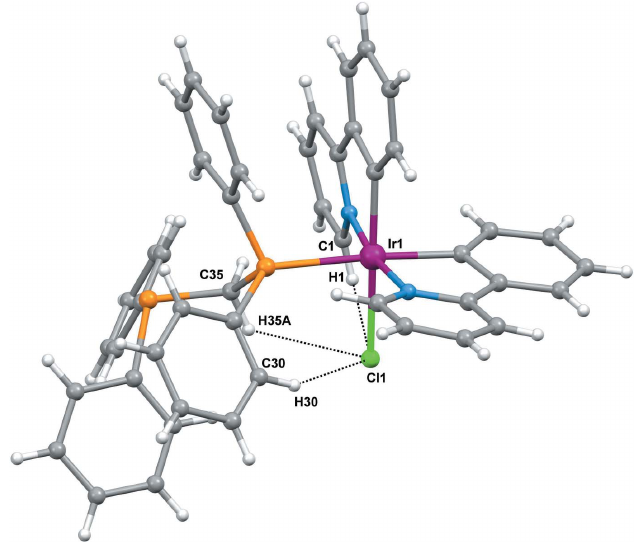
Figure 3 The intramolecular C—H (cid:3)(cid:3)(cid:3) Cl interactions in the title compound